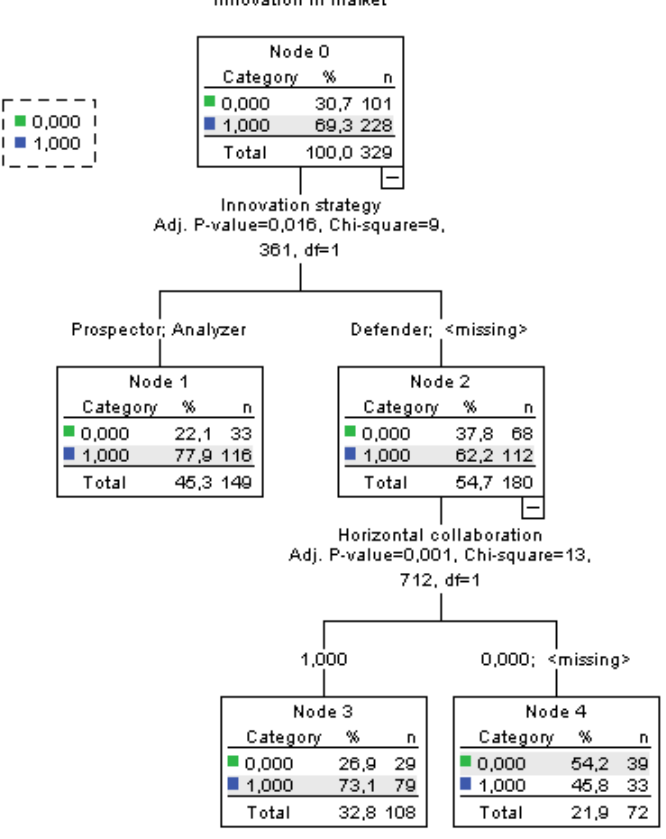
Figure 4. Determinants of innovation in